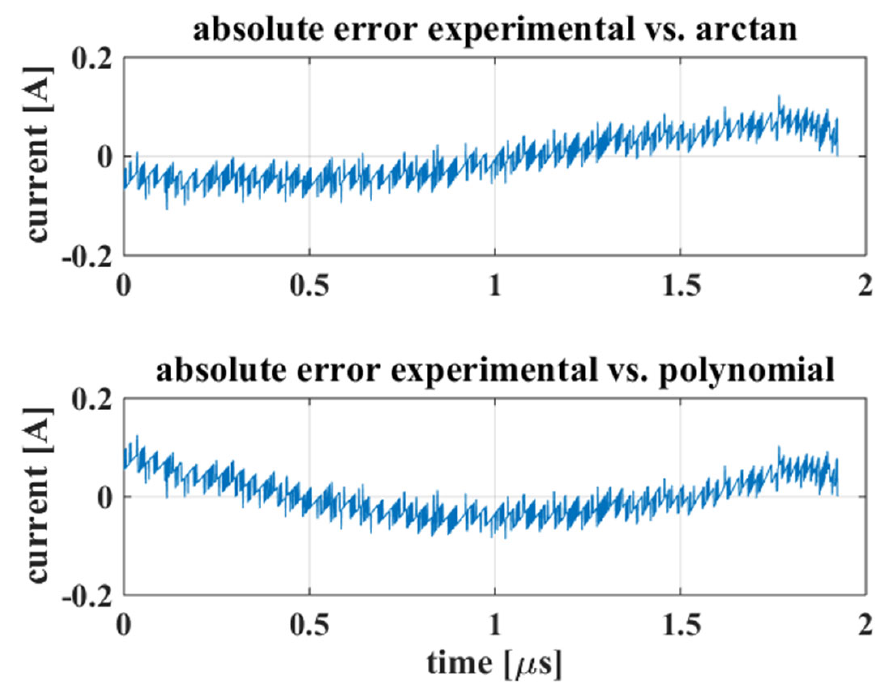
Figure 10. Absolute error between the experimental values and the current calculated by the two models.